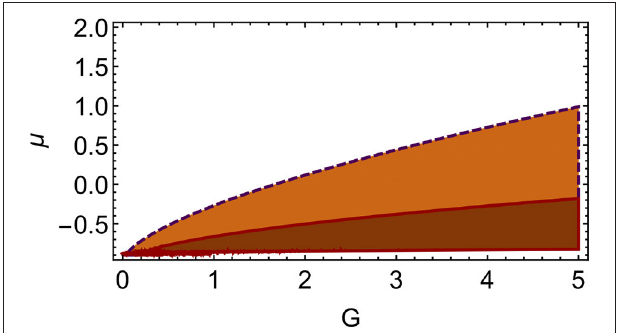
FIGURE 10 | The weak gravity bound in the ( G , µ Yang-Mills system (from Christiansen and Eichhorn, 2017) in orange, bounded by the dark dashed line, and the weak gravity bound in scalar-fermion systems (from Eichhorn et al., 2016; Eichhorn and Held, 2017) in dark red, bounded by the red continuous line, lie close to each